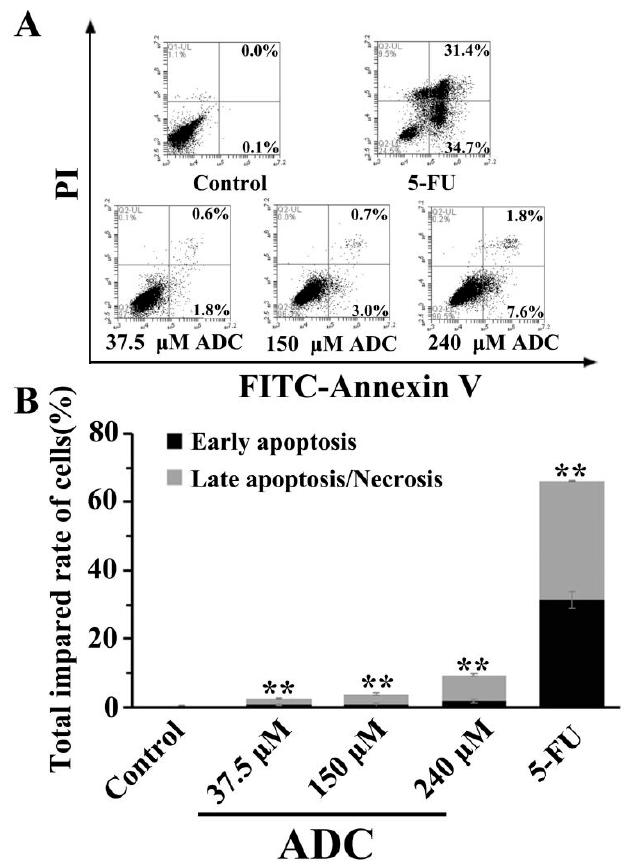
Figure 6. FCAS analysis of apoptosis. ( A ) Cells were incubated with the indicated doses (37.5, 150, and 240 µ M) of ADC for 72 h and apoptotic cells were observed with FCAS following annexin V-FITC/PI double staining. ( B ) The total impaired rate of cells in each group was calculated, ** p < 0.01 vs. control.